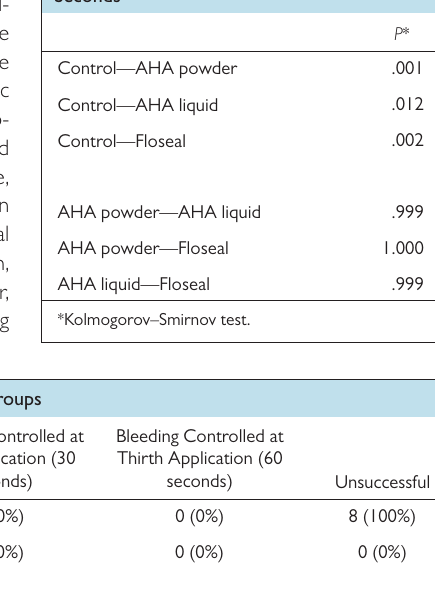
Table 2. The Effect of AHA Fluid, AHA Powder, and Floseal on Bleeding in the First